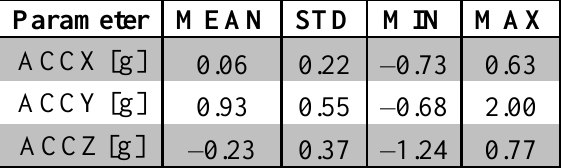
Table 6. Statistical analysis of experimental data acquired during a 20 s run.